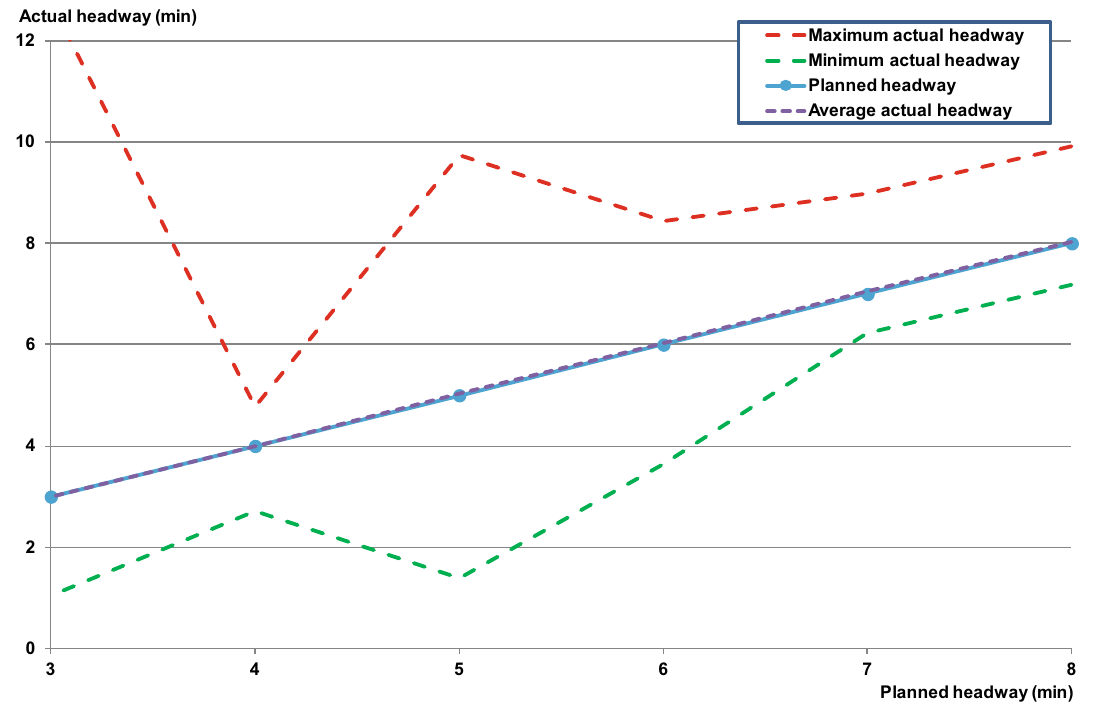
Fig. 9 Fluctuation band of actual headway—95th